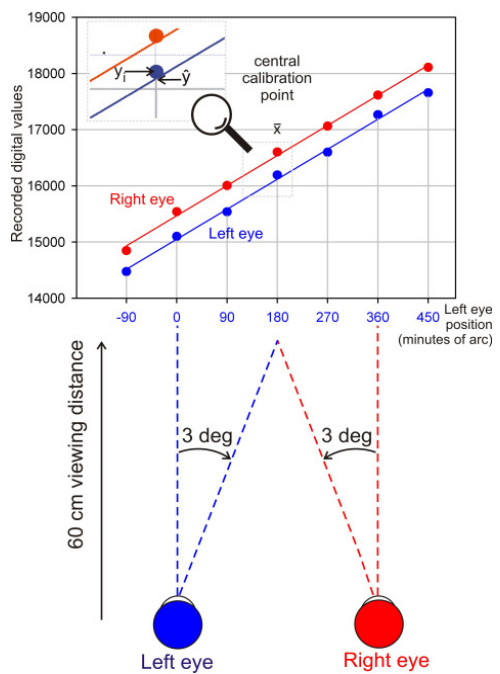
Figure 1: Example of typical calibration curves for the two eyes. Relative to the x-axis, the position of the two eyes is indicated at the